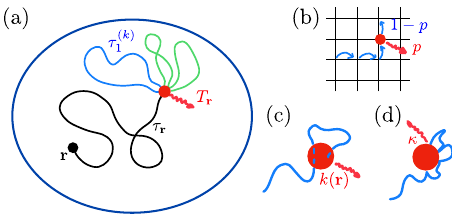
Fig. 1 Imperfect reaction kinetics in con fi nement. ( a ) In the case of imperfect reactions, multiple random interaction events between reactants are typically required before reaction occurs. The reaction time T r for a random walker starting from r with a target (red dot) can then be written is the total number of visits to the target before reaction, and τ ð k Þ return time to the target. ( b ) In the case of discrete space models, imperfect reactivity is parametrized by the probability p that reaction occurs at each visit of the random walker to the target. In the case of continuous space models, imperfect reactivity is modeled either by ( c ) a reaction rate k ( r ) when the random walker is within the reactive volume that de fi nes the target, or ( d ) partially absorbing boundary conditions (parametrized by κ ) at the target